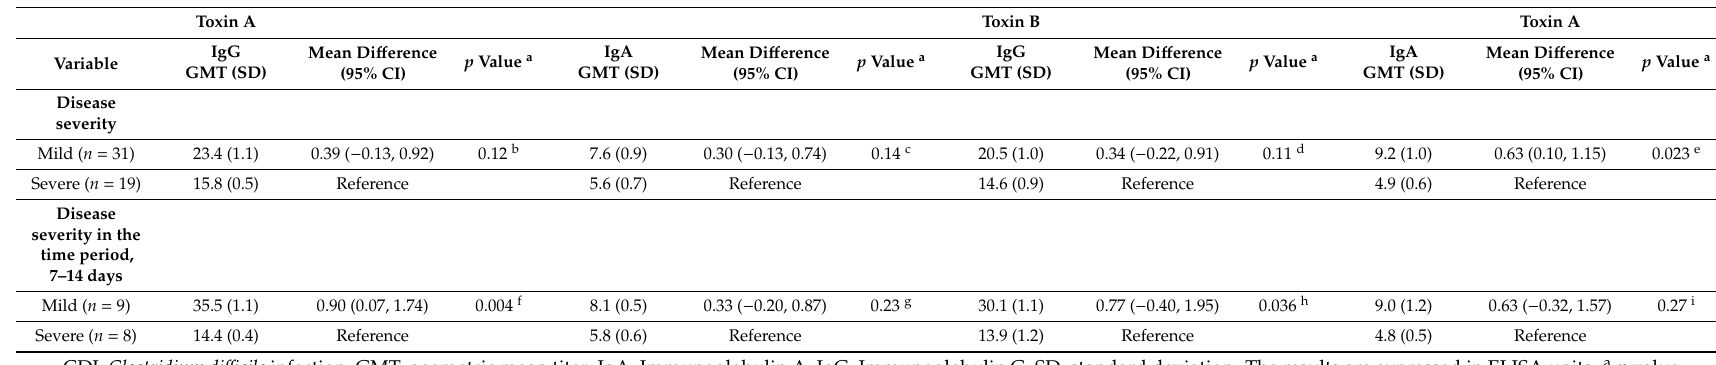
Table 2. Geometric mean titers (and standard deviations) of serum IgG and IgA antibody levels against toxin A and B of Clostridium di ffi cile among cases according to Clostridium di ffi cile infection (CDI) disease